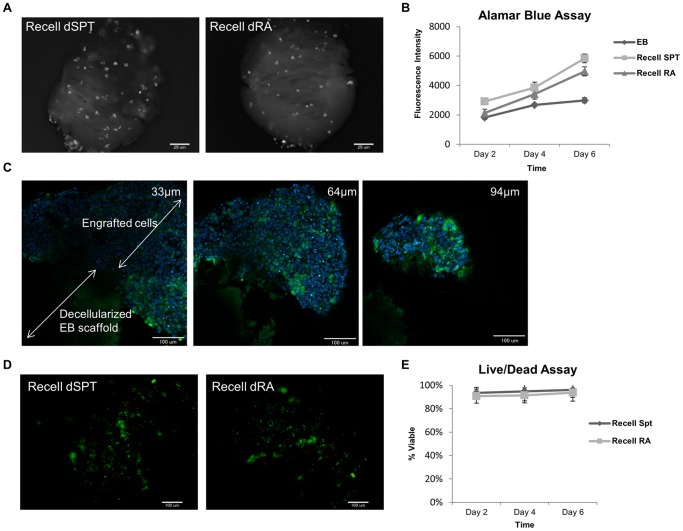
Examination of viability, engraftment location and proliferation kinetics of the seeded EB constructs.(A) Whole mount fluorescence images of seeded EB scaffolds at day 2 depict more ESR1 cells attach and grow on dSPT than dRA EB scaffolds. (B) Alamar blue assay depicts higher proliferation of ESR1 seeded on both decellularized EB scaffolds compared to native ESR1 EB over the course of 6 days. (C) Representative live/dead staining images show the survival of the engrafted ESR1 cells on both dSPT and dRA EB scaffolds after 2 days of culture. (D) Image analysis of live/dead assay to depict the mean percentage of live cells. (E) XY single-plane-two-photon imaging of cell-seeded constructs was done at depths of 33, 64 and 94 µm – this demonstrates that engrafted cells attached on the surface of the scaffolds with minimal infiltration into the ECM scaffold. All values are mean ± SD, n = 3, represents individual seeded EBs in 3 experimental repeats.